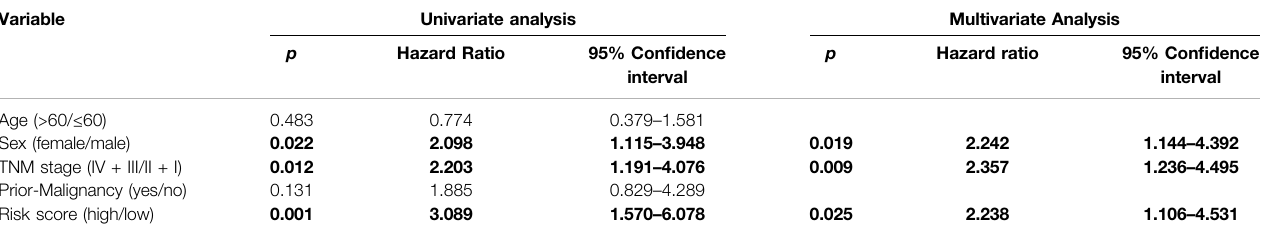
TABLE 5 | Univariate and multivariate regression analyses of OS in HCC patients of the ICGC dataset.